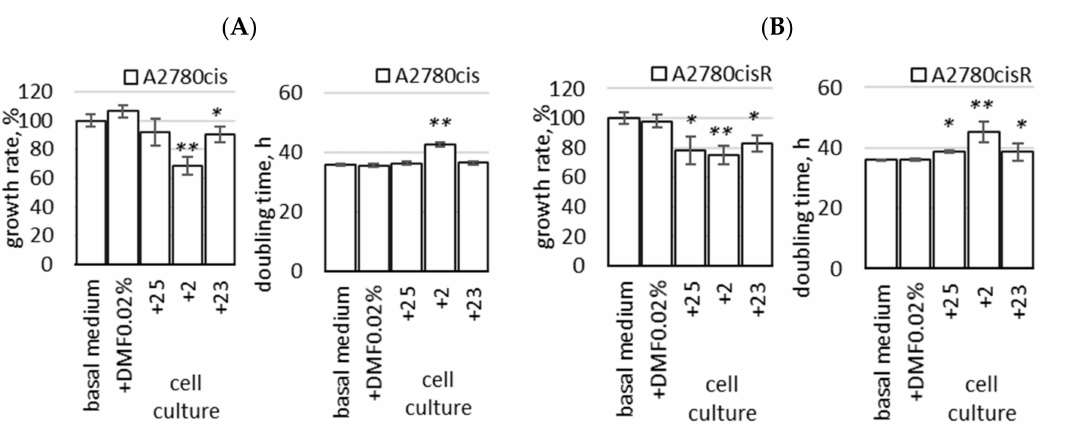
Figure 8. Growth rate and doubling time of A2780cis ( A ) and A2780cisR ( B ) cells cultured long-term in a medium with the addition of compound 23 (2 (cid:48) adenosine derivative modified with ferra bis(dicarbollide) ion); compounds 25 (analogous 2 (cid:48) derivative containing nido -7,8-dicarbaundecaborate) and 2 (unmodified ferra bis(dicarbollide)) were used for comparison. The cells were grown for two weeks in the basal medium with the addition of compounds 25 , 2 , and 23 (cultures named “+23_cells”, “+25_cells” and “+2_cels”) or without compounds (“basal medium” and “DMF 0.02%” control), as described in the Section 4. Cell growth rate is expressed as percentage of the number of control cells harvested at the end of the culture period (100%, equal to 7.5–10 × 10 6 cells). The mean values ± SEM of three experiments are shown. * p < 0.05, ** p < 0.01; Student t -test with Bonferroni correction was calculated for compounds versus control